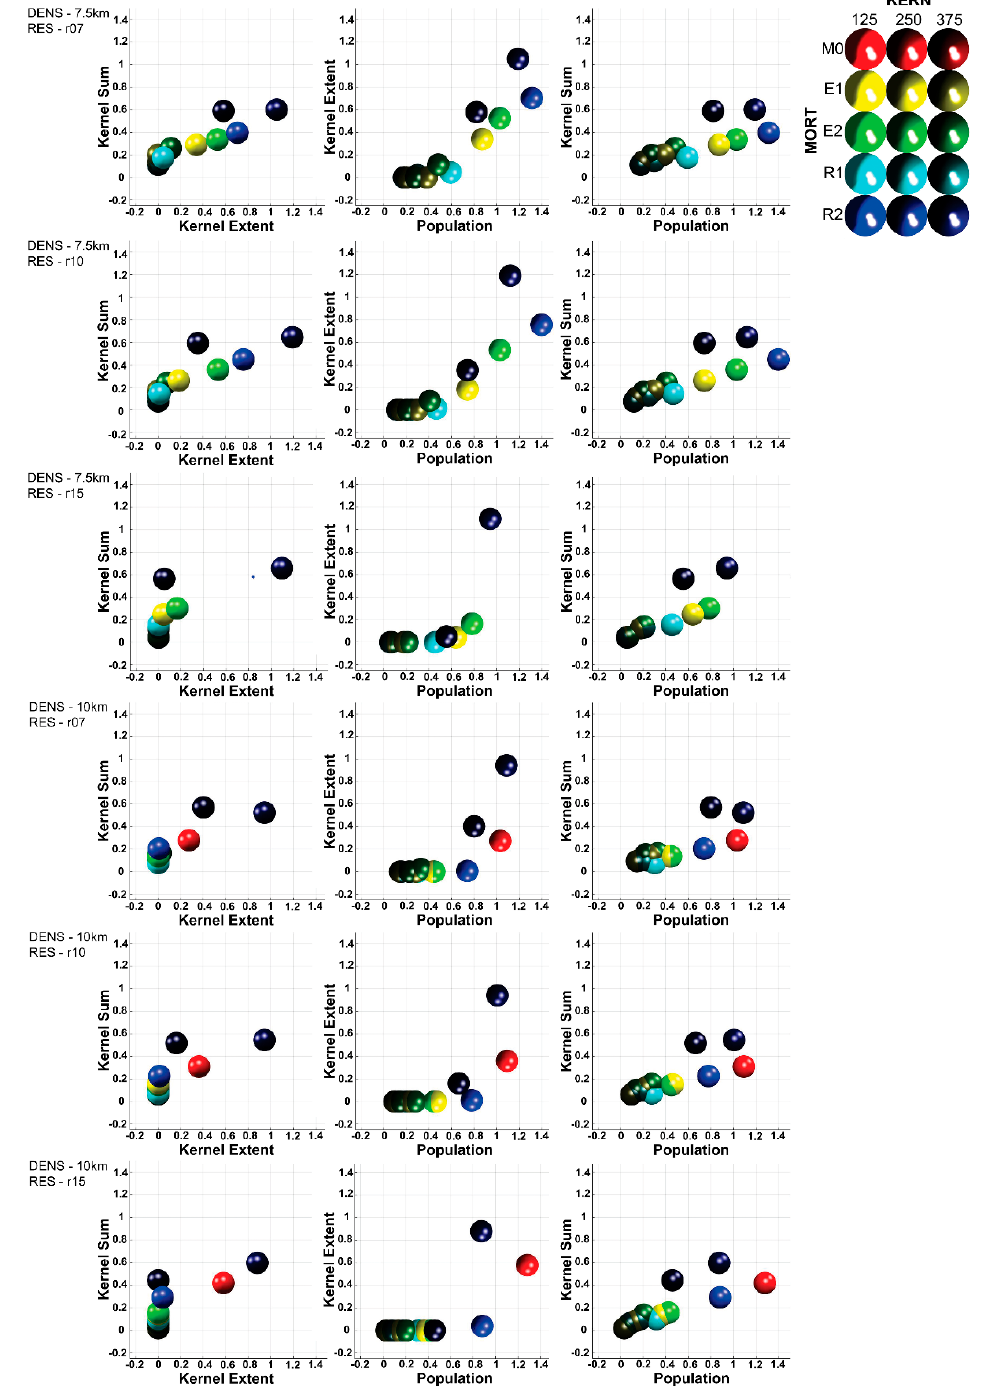
Figure 5. Three orthogonal views of the three-dimensional trajectory of scenarios in a space defined by kernel extent, sum kernel value, and population size, at timestep 6 across density (DENS) and resistance transformations (RES). Sphere color indicates different combinations of dispersal ability (KERN) and mortality risk (MORT). The figure shows that scenarios with low mortality risk (M0; red spheres) in which population density is high have much greater predicted kernel extent, kernel sum, and higher simulated population size (extreme values extending outside axis limits). Animations of these and other plots can be viewed in Supplementary Materials 3, Tables S13–S18.